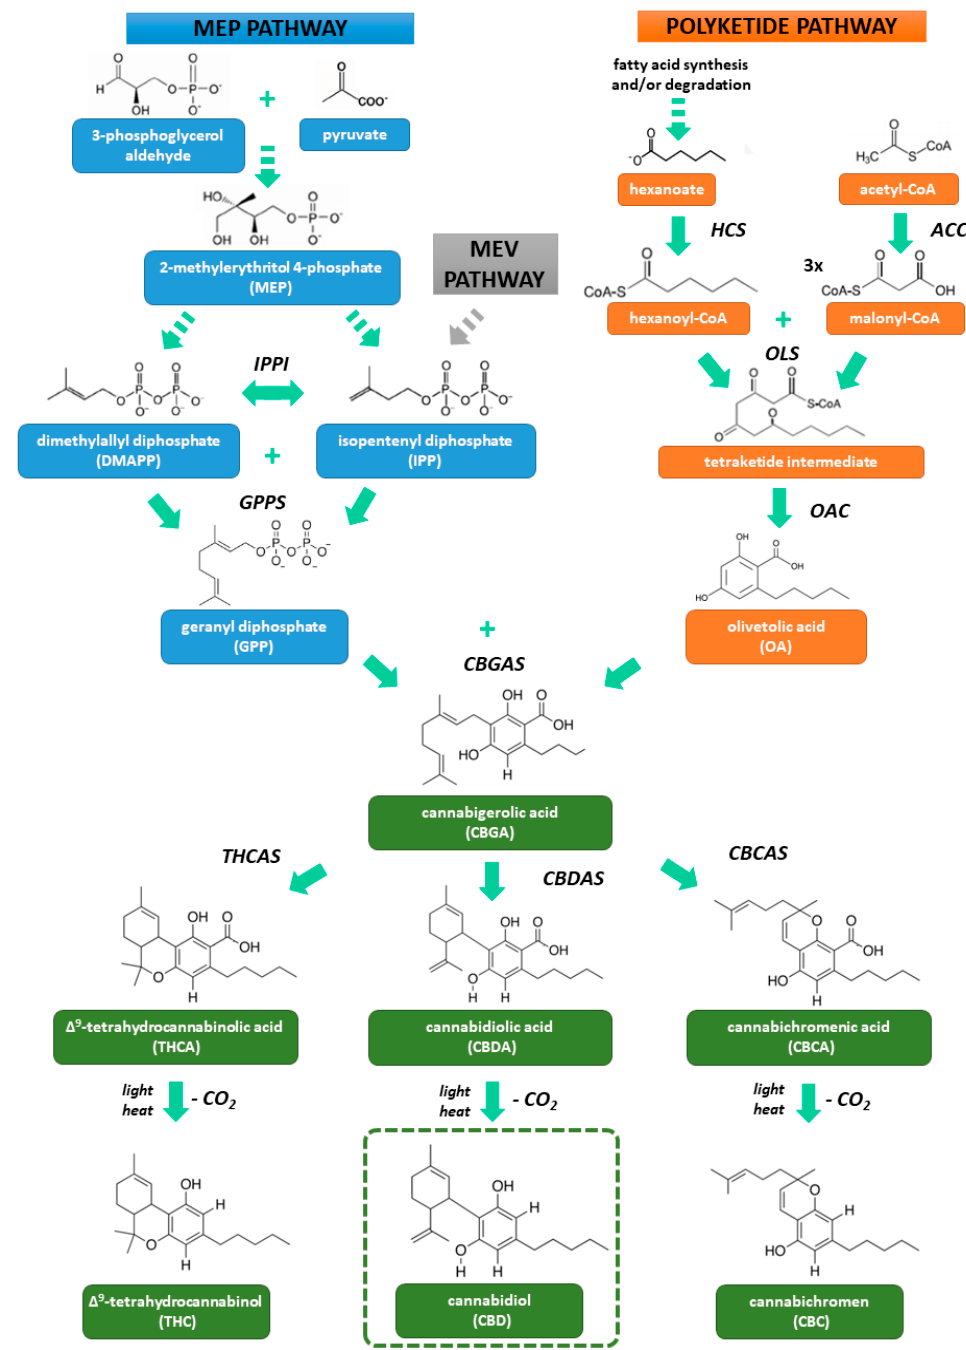
Figure 1. Biosynthesis of cannabidiol and other phytocannabinoids [1,42,43]. Abbreviations: ACC: acetyl-CoA carboxylase; CBCAS: cannabichromenic acid synthase; CBDAS: cannabidiolic acid and its synthase; CBGAS: cannabigerolic acid synthase; GPPS: geranyl diphosphate synthase; HCS: hexanoyl-CoA synthetase; IPP: isopentenyl diphosphate; MEV: mevalonic acid; OAC: olivetoleic acid cyclase; OLS: olivetol synthase; THCAS: Δ 9 -tetrahydrocannabinolic acid synthase.